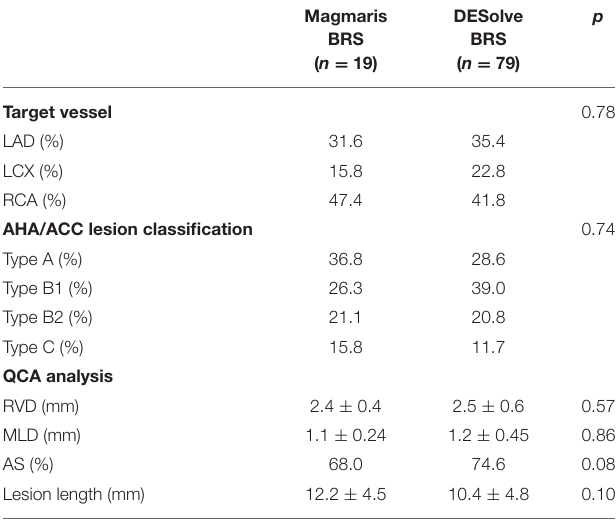
TABLE 1 | Baseline characteristics. TABLE 2 | Angiographic and QCA lesions